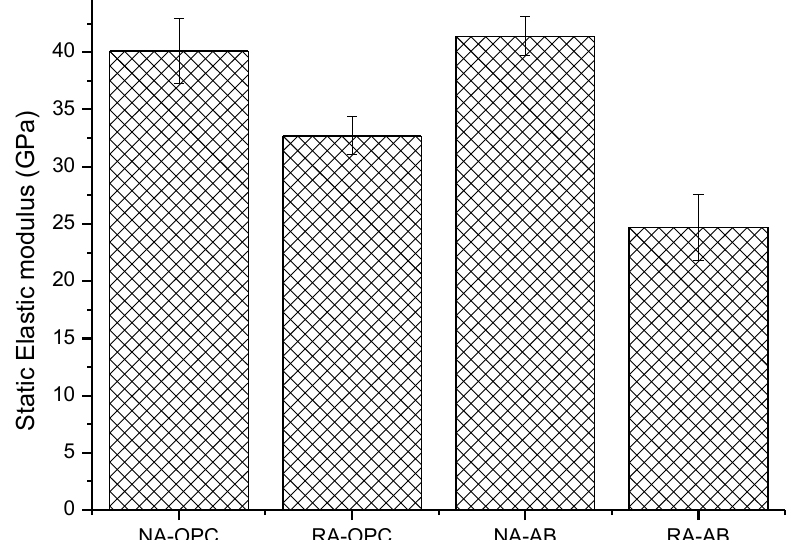
Figure 3. Static Elastic modulus of concrete specimens. Standard deviation is plotted as error